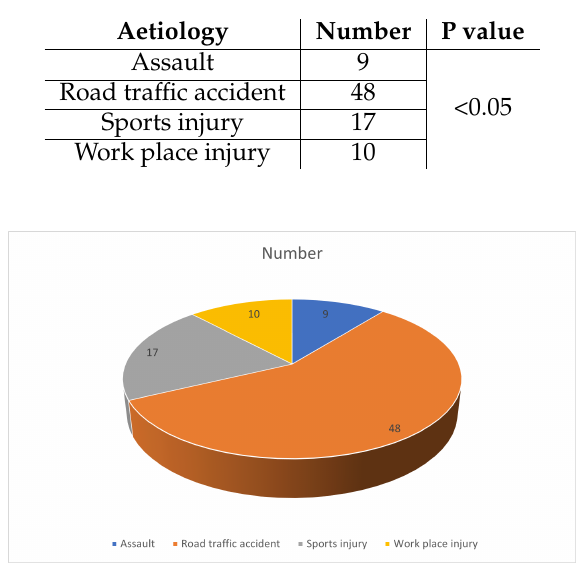
Table 2. Aetiology of injury